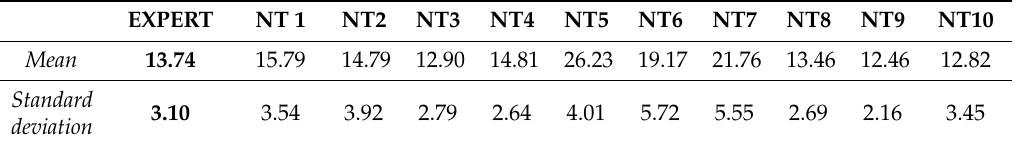
Table 1. Expert session statistics for the parameter relative to task time (in seconds) compared with the session statistics of ten novice trainees (NT) for an equivalent number of individual simulator training trials (N = 120) across camera view